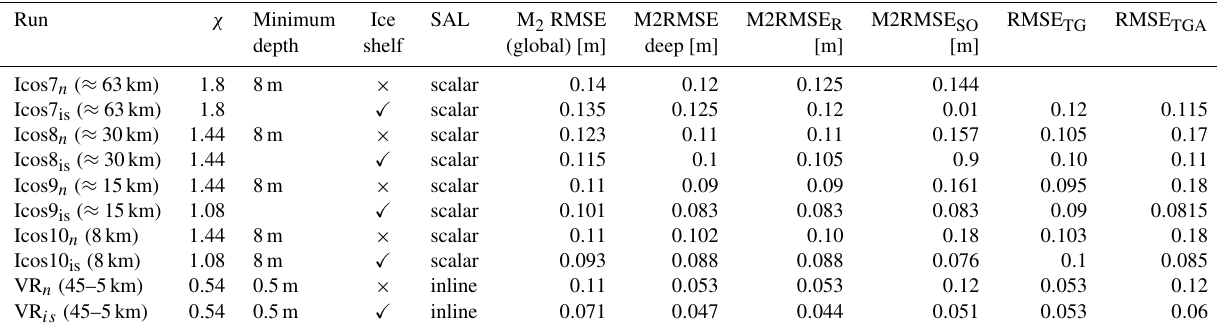
Table 1. RMSE values of the M 2 tidal constituent, calculated for different simulations (Icos7 n –VR is ). “M2RMSE (global)” refers to the global RMSE value calculated without any ocean depth restrictions; “M2RMSE deep” refers to the global RMSE value calculated over ocean depths > 1000m. M2RMSE R refers to RMSE values calculated between 66 ◦ N and 66 ◦ S and for ocean depths > 1000m. M2RMSE SO refers to the RMSE values calculated over the Southern Ocean only, i.e., for latitudes south of 60 ◦ S; RMSE TG refers to RMSE values obtained from the “Truth Pelagic” tide gauge database; RMSE TGA refers to RMSE values obtained from the UHSLC tide gauge database along the Antarctic coastline.